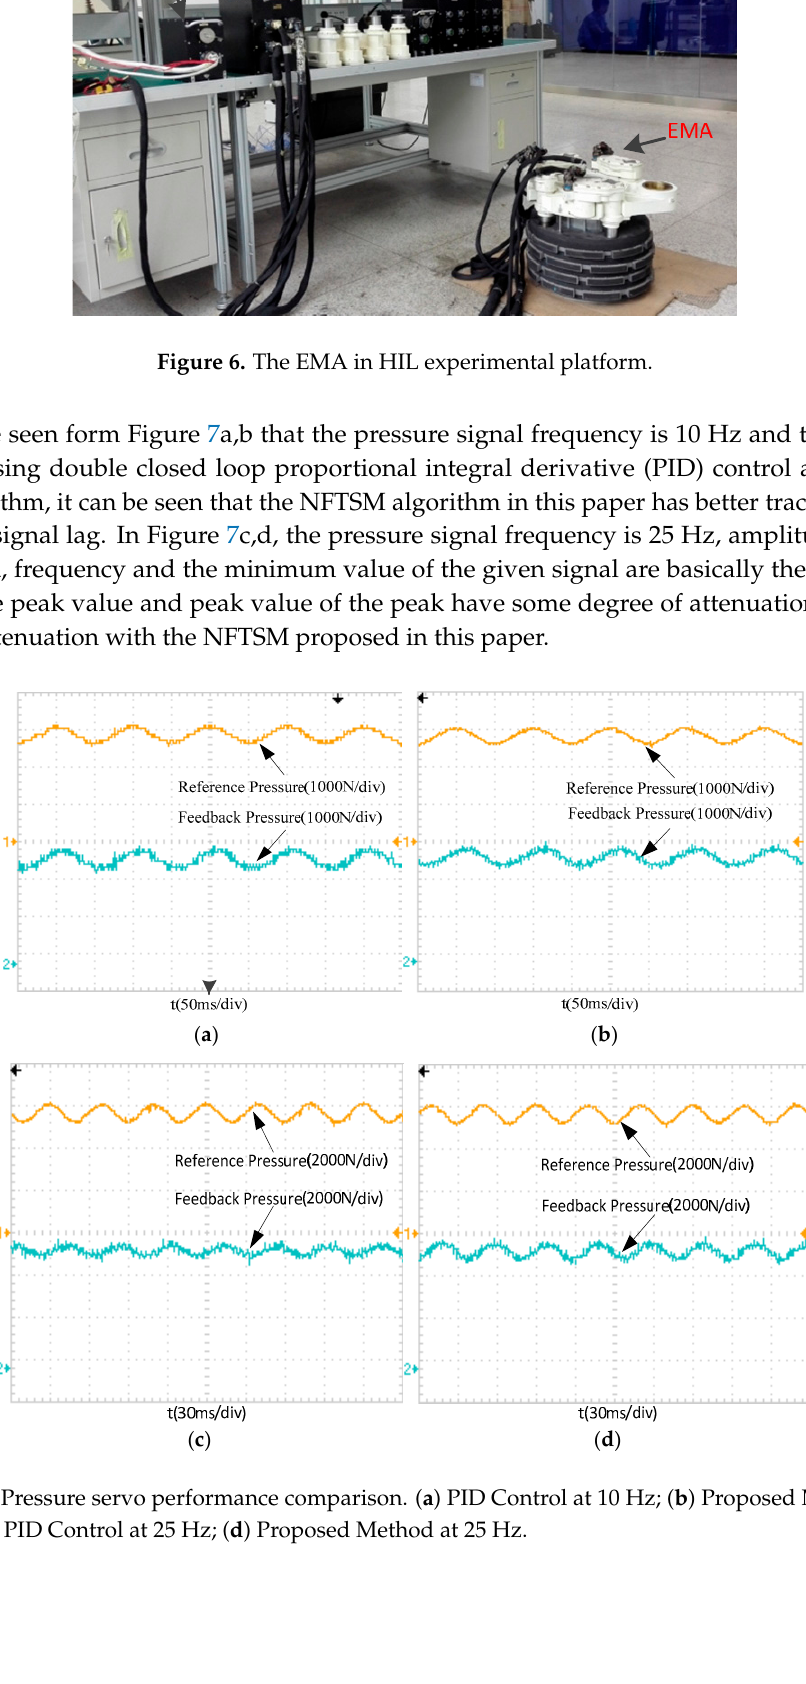
s t ( b ) Figure 8. HIL Results. ( a ) Velocity of the aircraft and wheel speed; ( b ) Slip ratio. Figure 8b shows the slip rate tracking error is gradually increasing during the braking process, which indicates the slip rate tends to show extraordinary characteristics when the plane tends to stop, but the brake point is still located in the stable region. It should be noticed that when the braking process is ended and V x = 0 (the braking speed), the slip rate is singular. There is no divergent slip phenomenon tends in ideal mathematical model. By taking consideration of the changing wheel load, landing gear buffering, runway roughness, tire compression characteristics, a small changes of ω (the wheel speed) will lead inevitably to some perturbation of the wheel line speed influenced by the torque. In the high - speed stage, the aircraft speed is big enough to avoid dynamic perturbation effects on slip rate caused by ω with little fluctuation, however, it will cause a strong influence on the slip rate when ω is little, which is the inherent characteristics of the slip ratio control. Therefore, with the existing control method it is difficult to avoid the low speed slip rate from alternating. The curve seems to have a great influence on the control results, whereas this is not the core problem of slip rate control in practical applications. The target slip ratio tracking effect is not obvious at low speed. The braking wheel is allowed to lock at the end of the braking process in an icy runway. If the speed is low enough, the pilot can manually brake or use maximum pressure to brake the aircraft without an anti-skid braking system. 5. Conclusions Based on the analysis of the working principle of all-electric braking system, a mathematical model of the EMA pressure servo system is established, and the state space model with matching